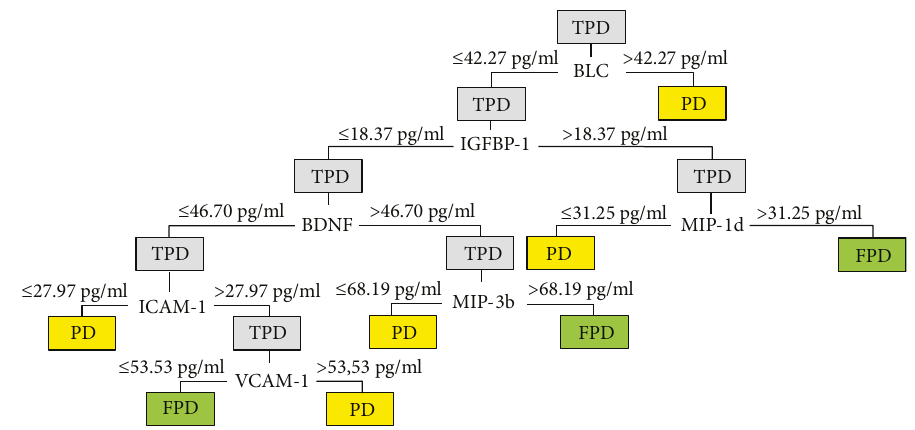
Figure 1: Diagnostic model to di ff erentiate preterm delivery from false preterm delivery on the basis of biochemical markers concentrations. TPD: threatened preterm delivery; PD: preterm delivery; FPD: false preterm